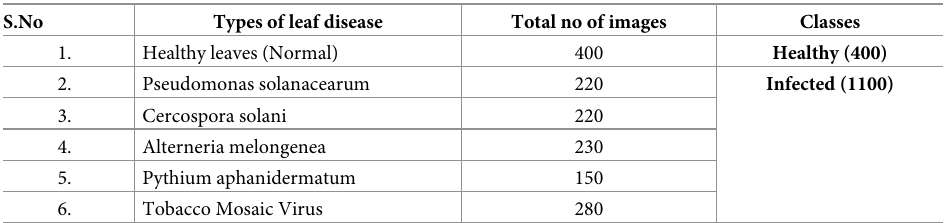
Table 1. Details of leaf